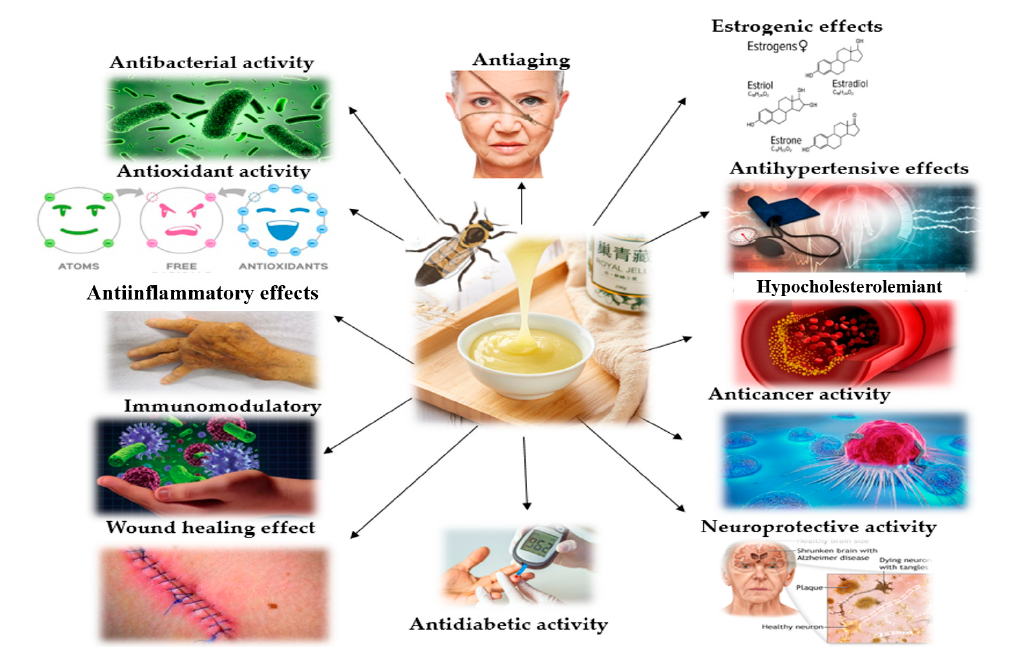
Figure 1. Biological properties of royal jelly [9] .